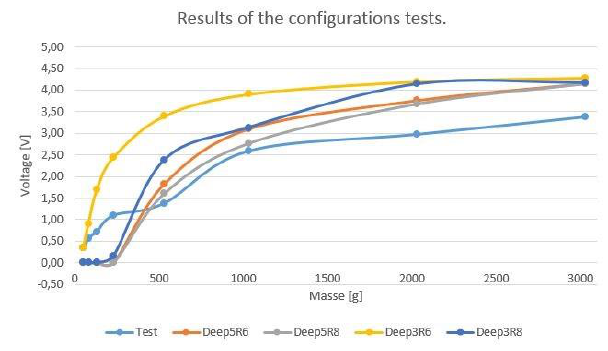
Figure 11. Overall behaviour of the sensor response vs the different experimental configurations. The blue Test plot refers to the test as performed without any silicon